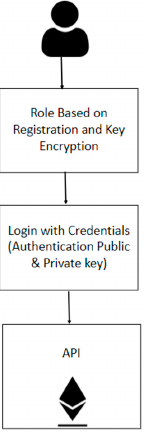
Figure 7. Add user in